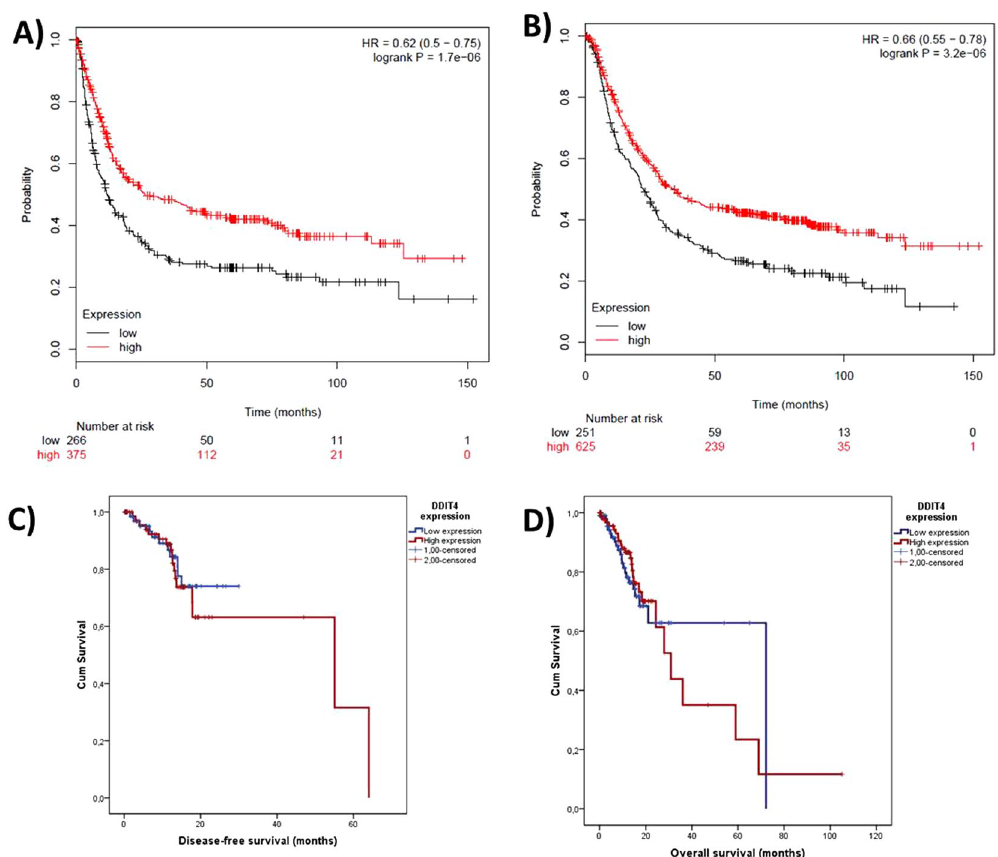
Figure 4. Analysis of pooled gastric cancer datasets contained in KM-Plotter. It showed that a high DDIT4 expression is related with a good prognosis in ( A ) time to first progression [N = 646; P = 1.7 × 10 − 6] and in ( B ) Overall survival [N = 876; P = 3.2 × 10 − 6]. However; data of gastric adenocarcinoma downloaded from the TCGA project show not association between DDIT4 expression and the ( C ) disease-free survival [N = 148; P = 0.870] or ( D ) overall survival [N = 208; P =